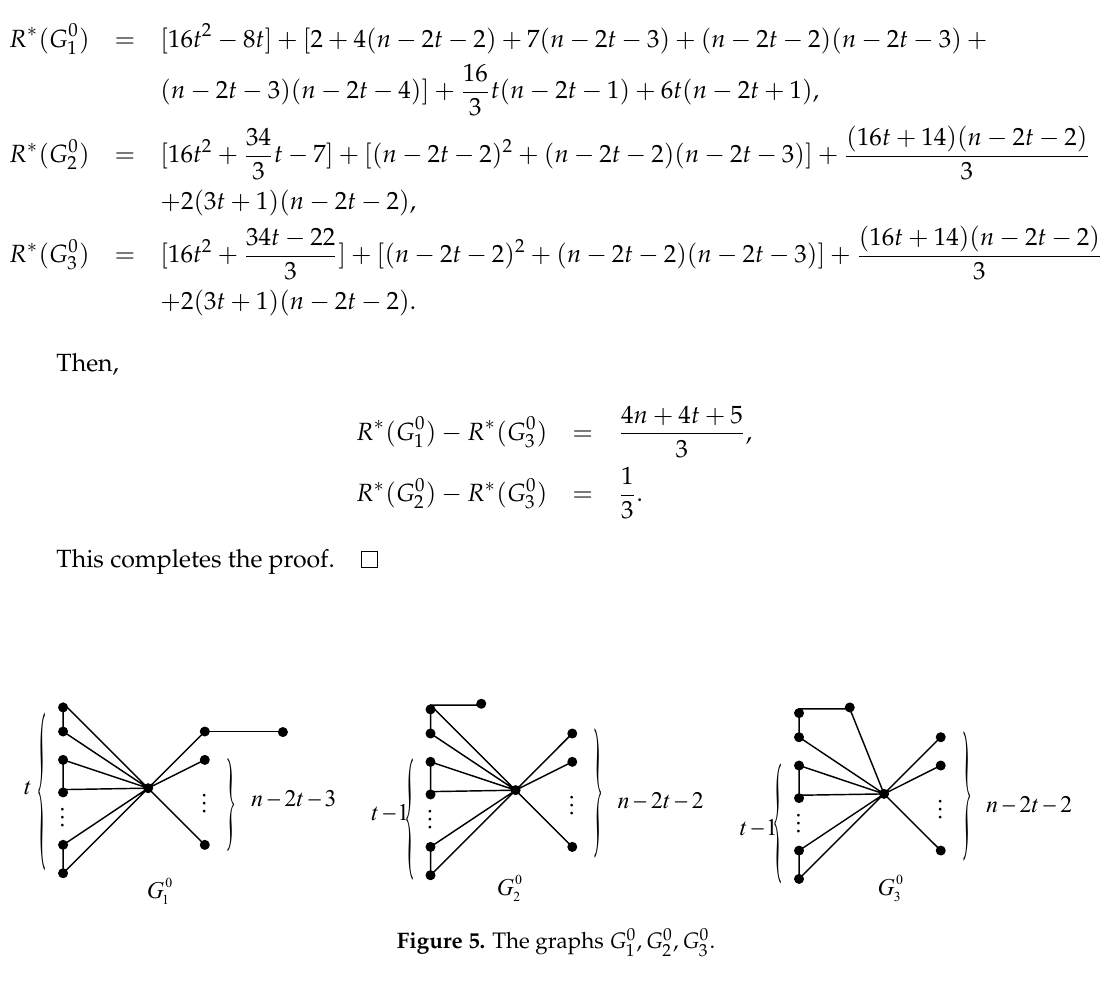
Figure 5. The graphs G 0